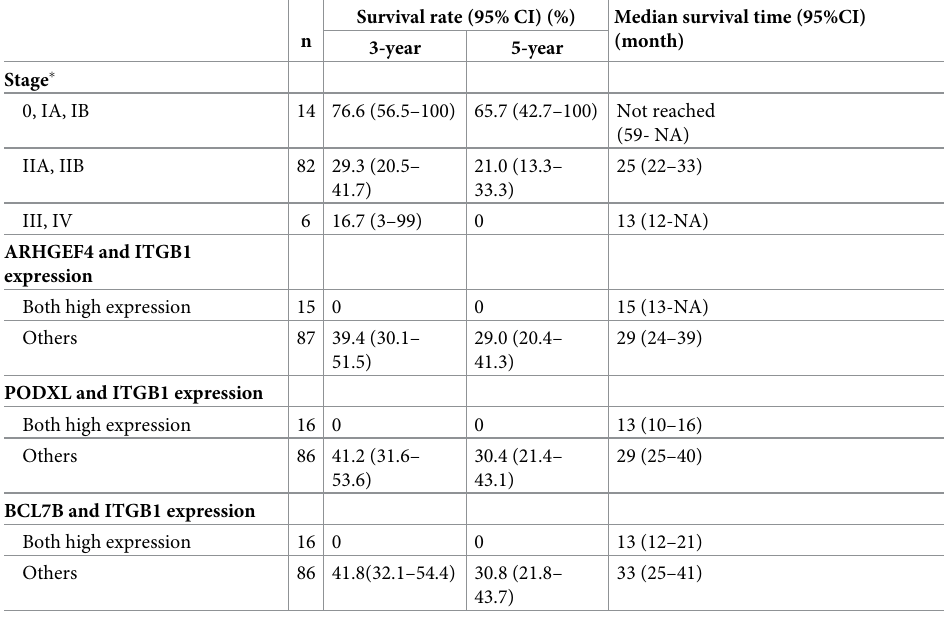
Table 7. The 3-year and 5-year survival rates and median survival